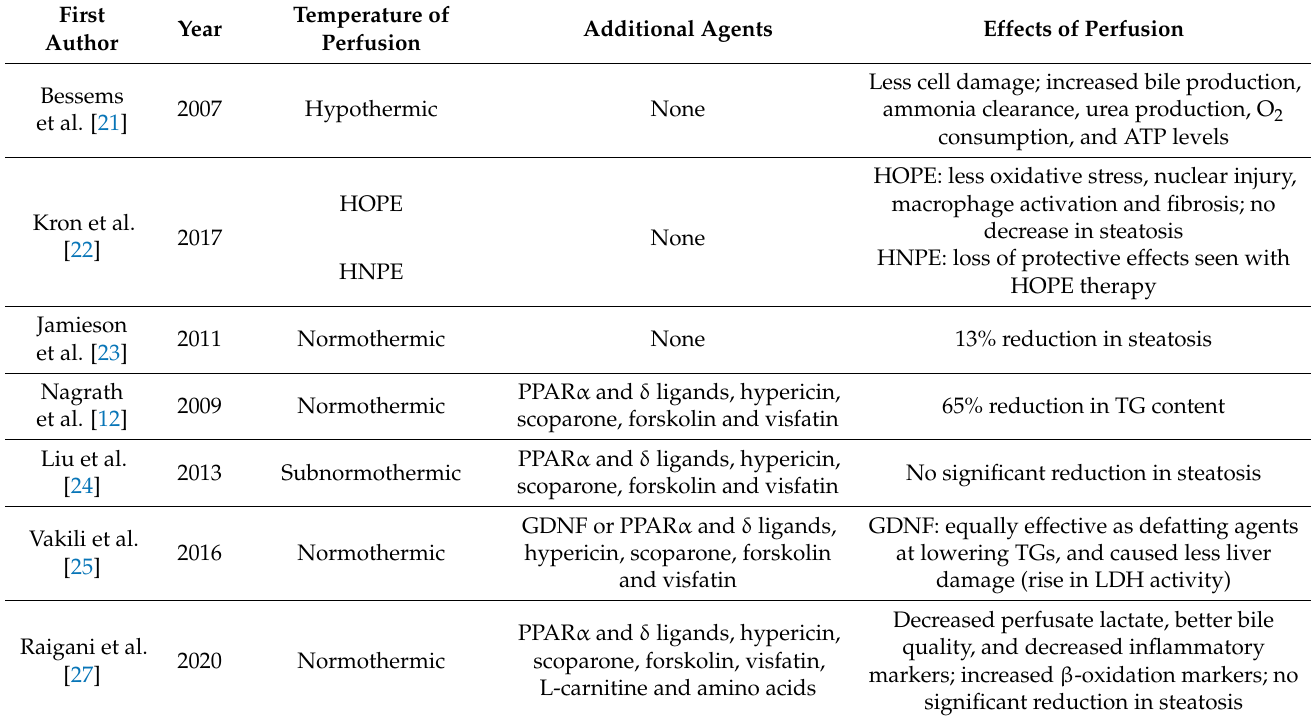
Table 2. Summary of Machine Perfusion Techniques–Preclinical